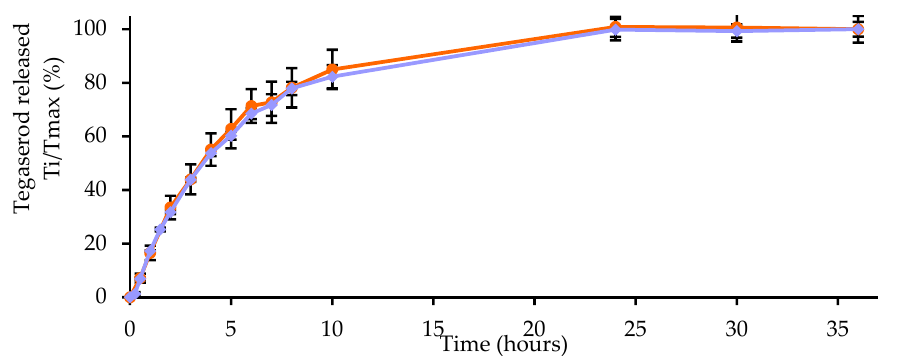
Figure 6. Tegaserod release profile from Tg-NEs (in blue) and Tg-NEs-P22 (in orange) in PBS pH 7.4 ( n = 3, data are shown as the mean ± SD).